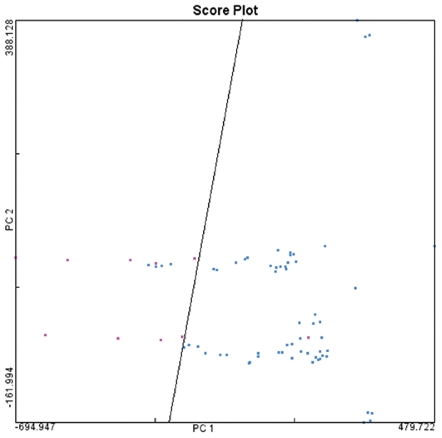
The first two principle components plot of AD and schizophrenia drugs based on their docking score vectors.The figure demonstrates that 10 AD drugs (red) could be basically separated from 63 schizophrenia drugs (blue) linearly.